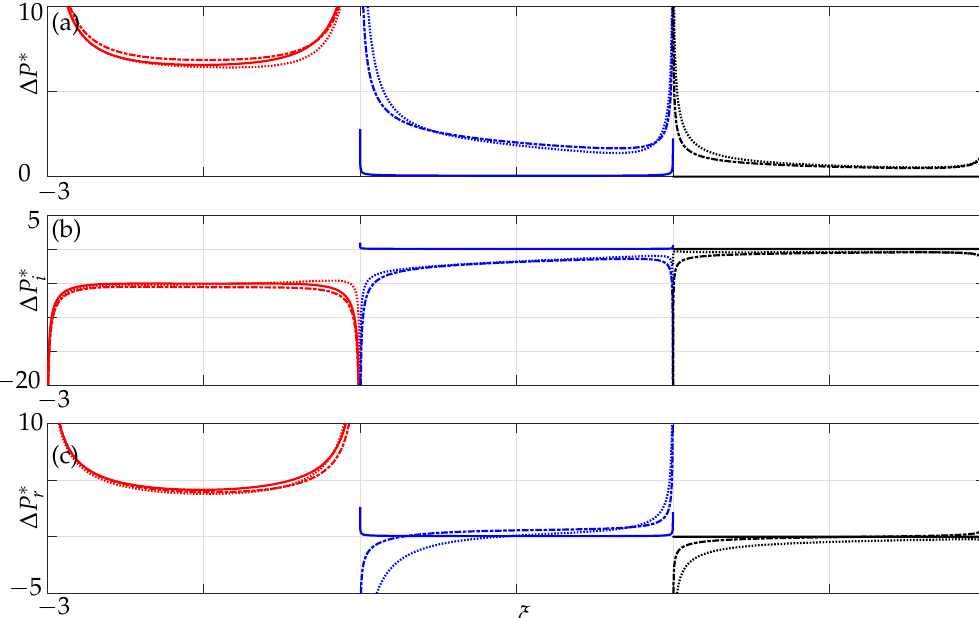
Figure 8. Variation of the ( a ) absolute, ( b ) imaginary and ( c ) real values of nondimensional pressure difference across three beams incorporating only the nearest neighbour influence at Re = 1; solid lines: ¯ g = 8, dash–dotted lines: ¯ g = 0.4, dotted lines: ¯ g = 0.1, with the left-most beam active and the rest